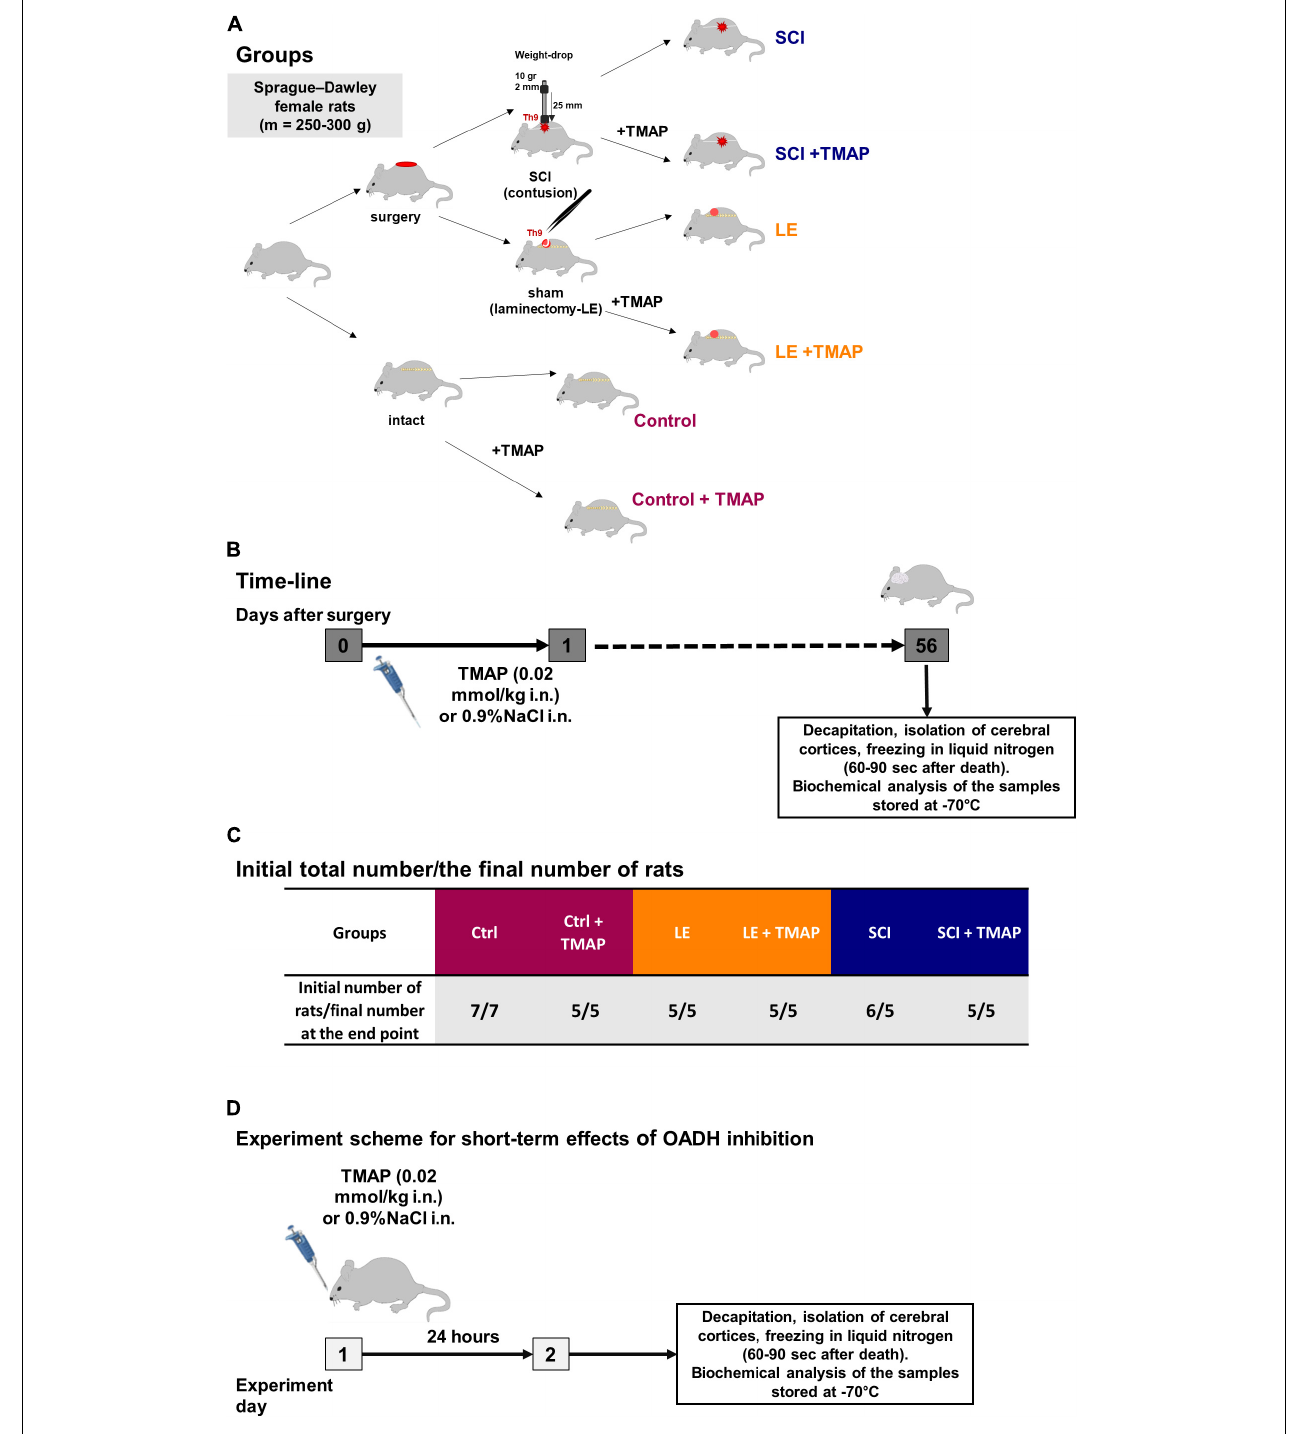
FIGURE 2 | Experimental flow-chart. (A) An overview of experimental procedures for each animal group in SCI model. (B) Timeline of the procedures in SCI model. (C) Distribution of rats across the groups in SCI model with initial and end point number of animals in each group. (D) Timeline of the procedures in the study on short-term effects of the OADH-directed inhibitor TMAP. The color code of the experimental groups, given in (A,C) , is employed in the following presentation of the results in different figures.